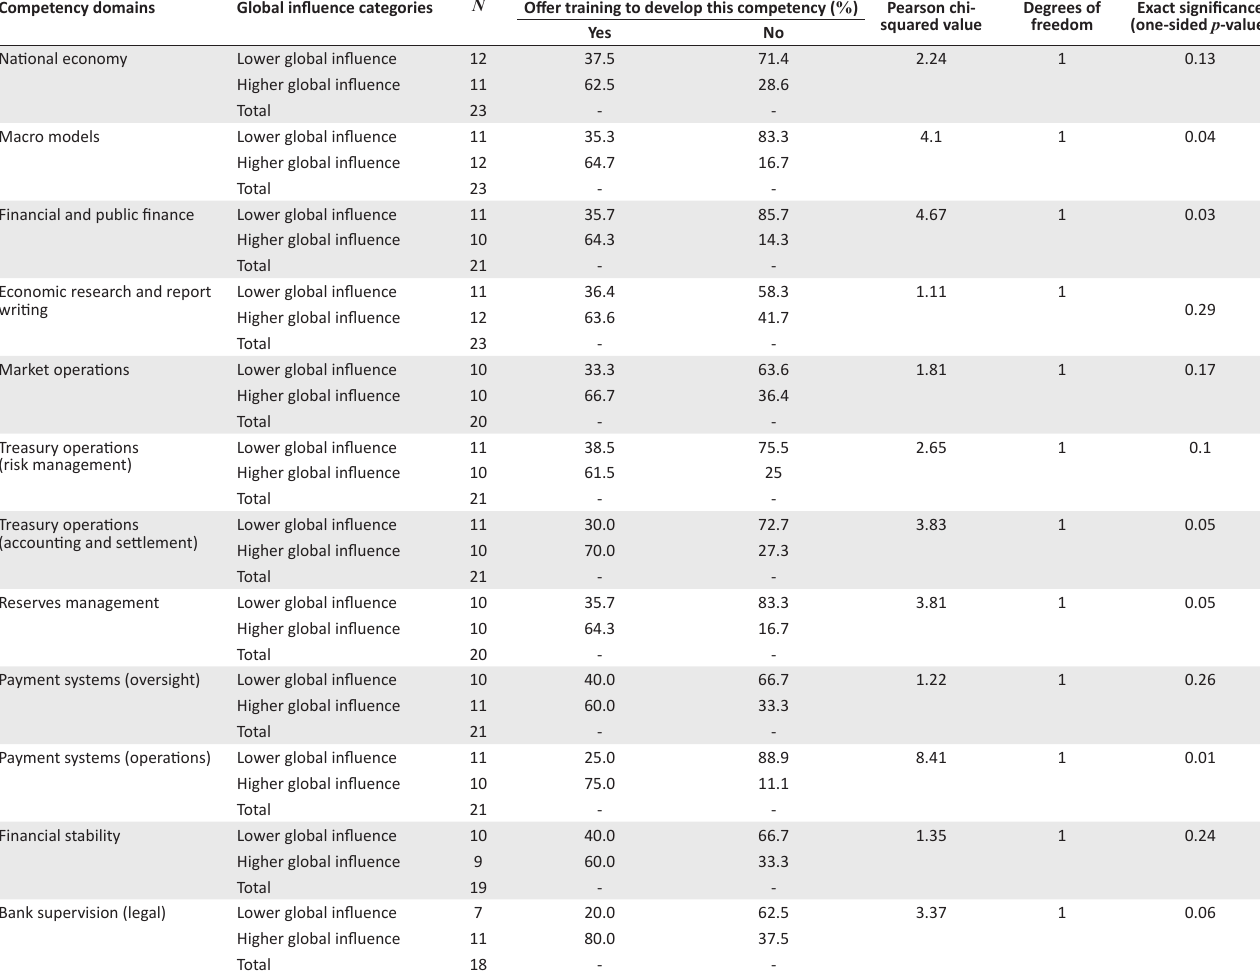
TABLE 8: Hypothesis testing: Degree of global influence and training offered: Results of Pearson’s chi-squared test.